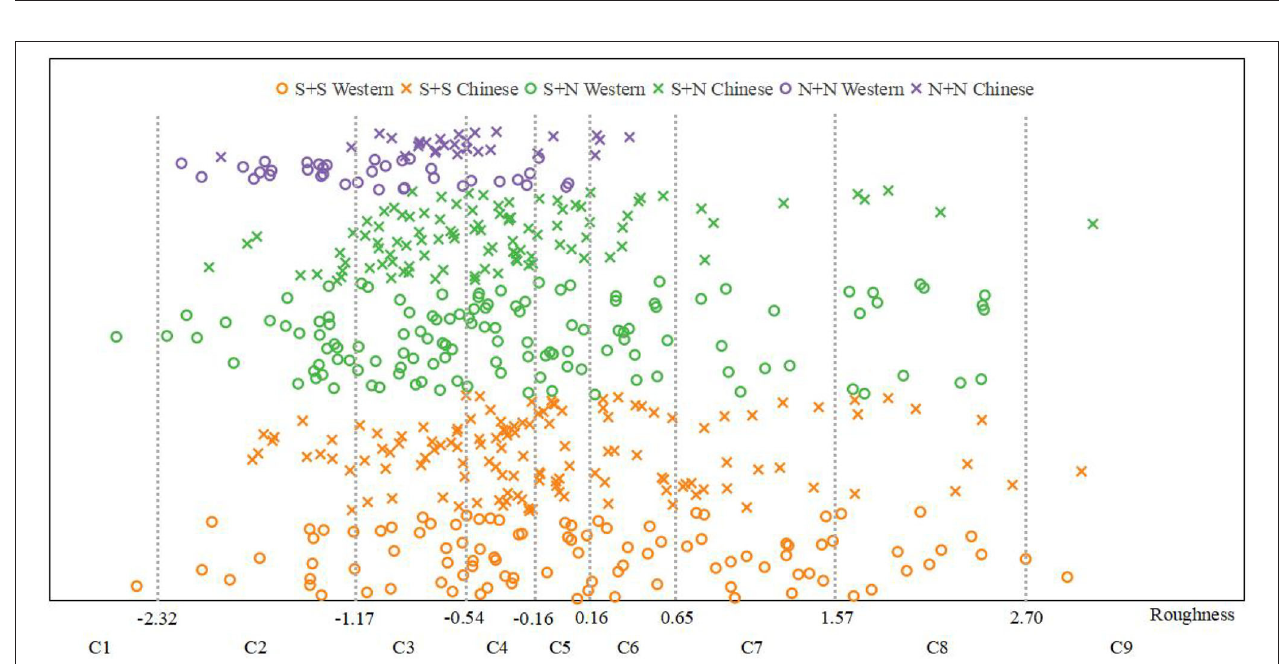
FIGURE 6 | Roughness psychological